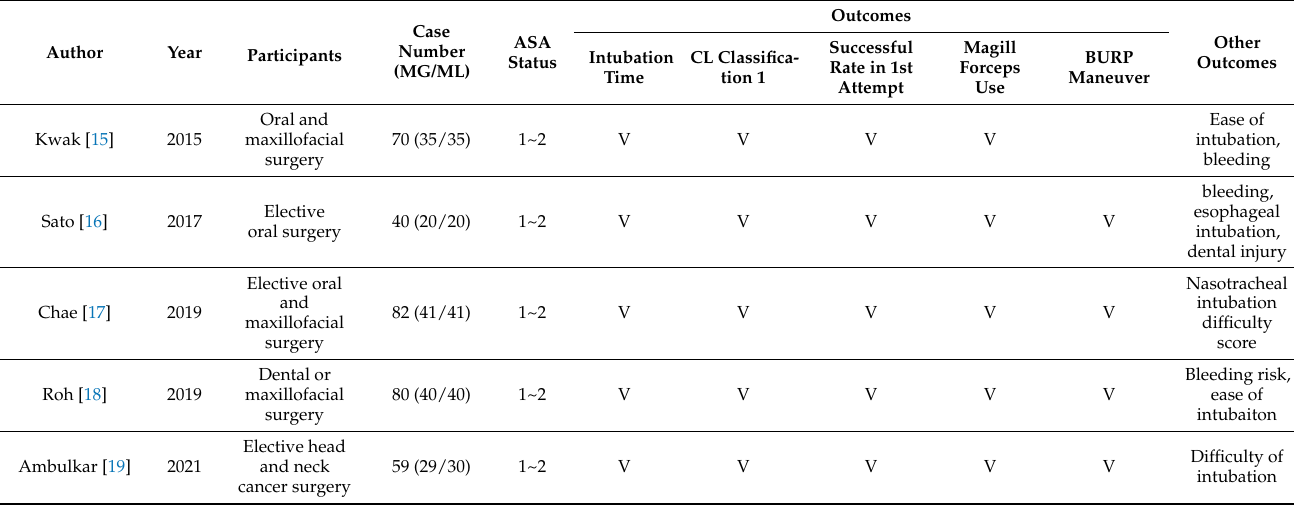
Table 1. The summary of the characteristics of included